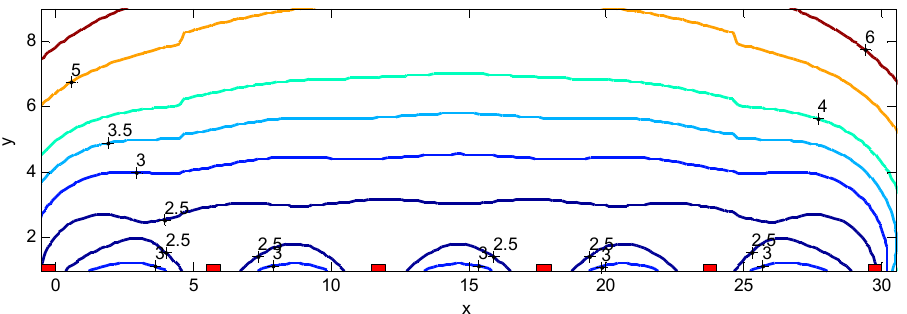
Figure 5. Deviation of the location estimate of the mobile wireless device (MWD) based on six access points (Aps) shown as red rectangles separated by 6 m and the contour labels indicating the MWD location deviation in meters.